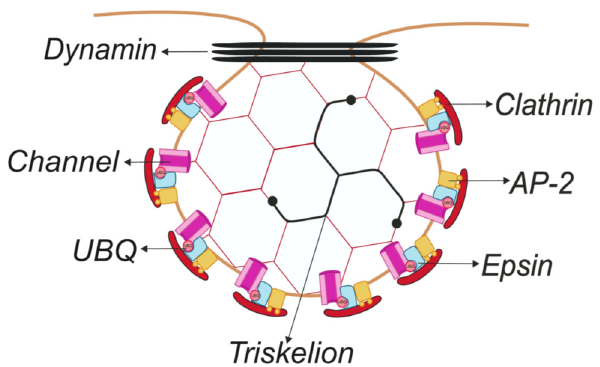
Figure 1. Schematic representation of the clathrin-coated pit (CCP) structure. Clathrin, the major protein in CCPs, forms a triskelion that polymerizes to form a hexagonal coat that covers the membrane. The AP-2 complex links clathrin to the membrane and coordinates the assembly of the coat with cargo proteins and lipids. In addition, epsins couple ubiquitinated membrane proteins into CCPs and contribute to the membrane curvature during the formation of clathrin-coated buds. Finally, dynamin catalyzes the constriction of the “neck” of the membrane invagination and the scission of the clathrin-coated vesicles (CCVs) from the plasma membrane. See the text for further details. Color code: red, clathrin; orange, AP-2 complex; blue, epsin; black, dynamin; light red circle, ubiquitin; and pink,